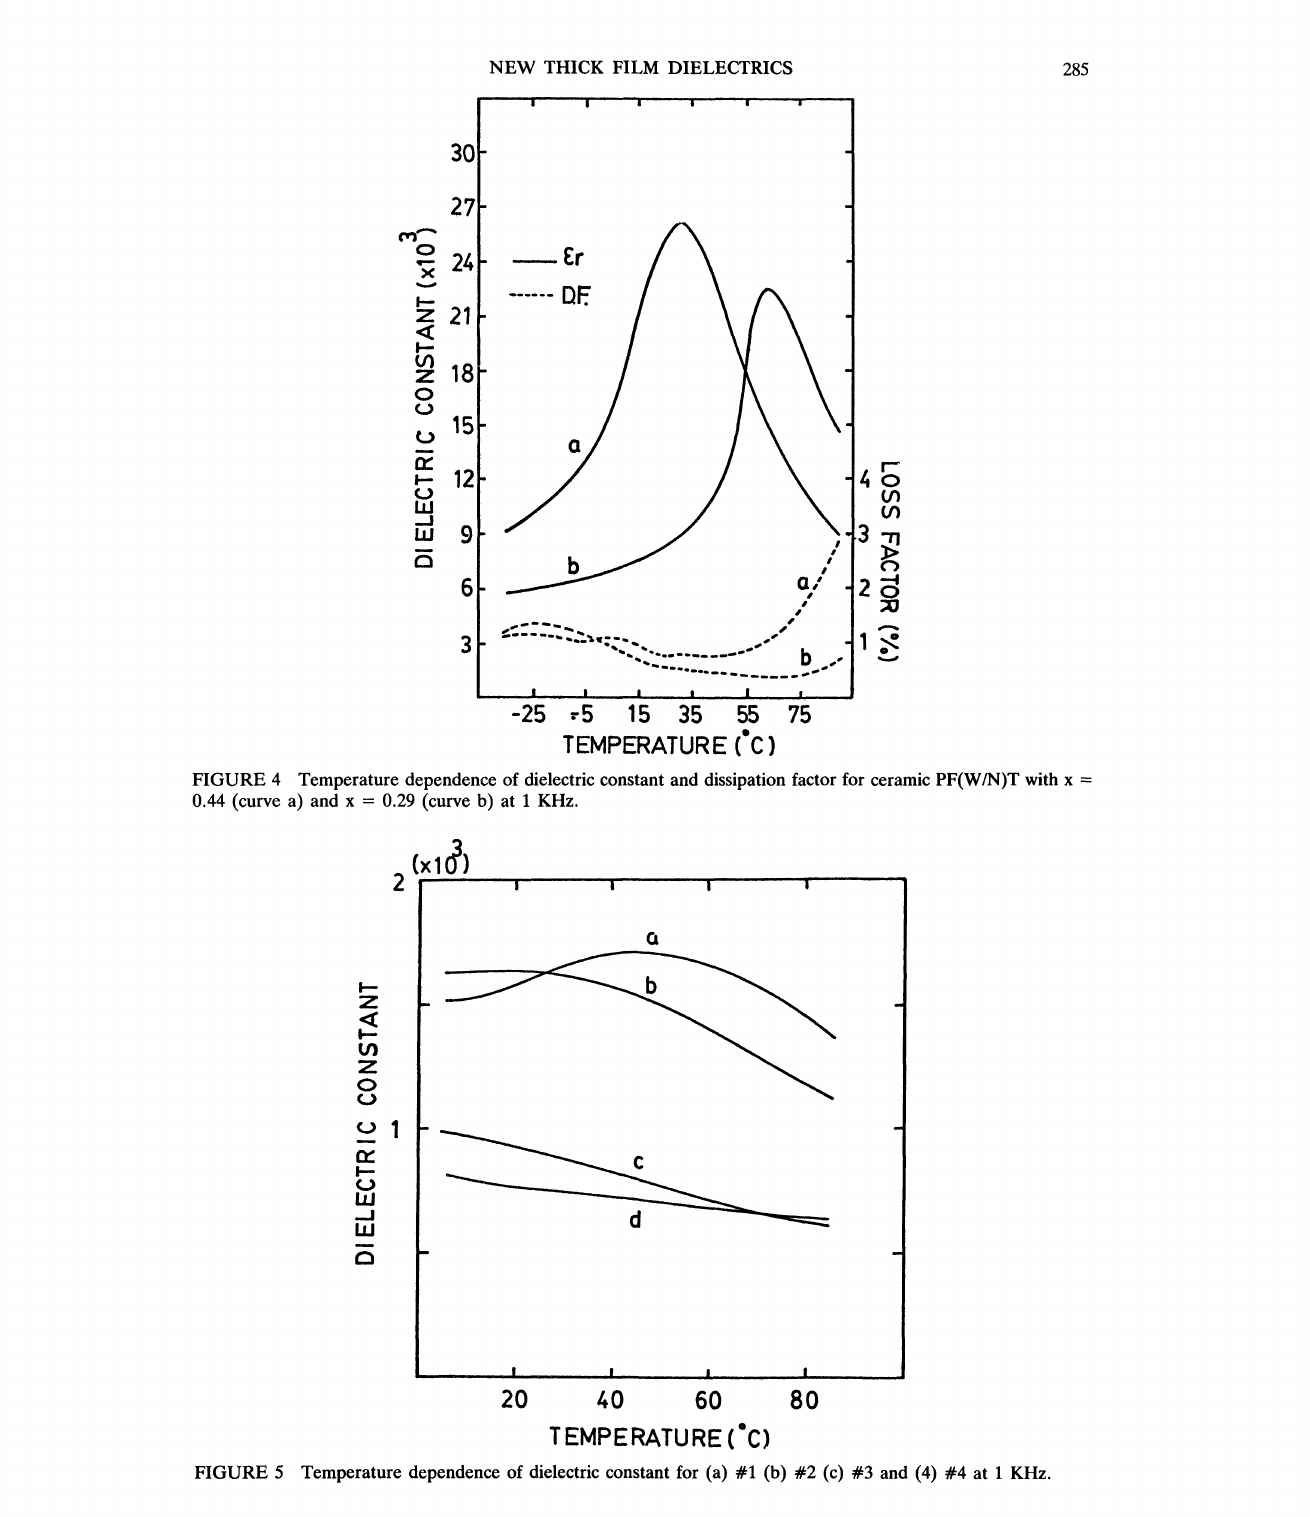
FIGURE 5 Temperature dependence of dielectric constant for (a) #1 (b) #2 (c) #3 and (4) #4 at